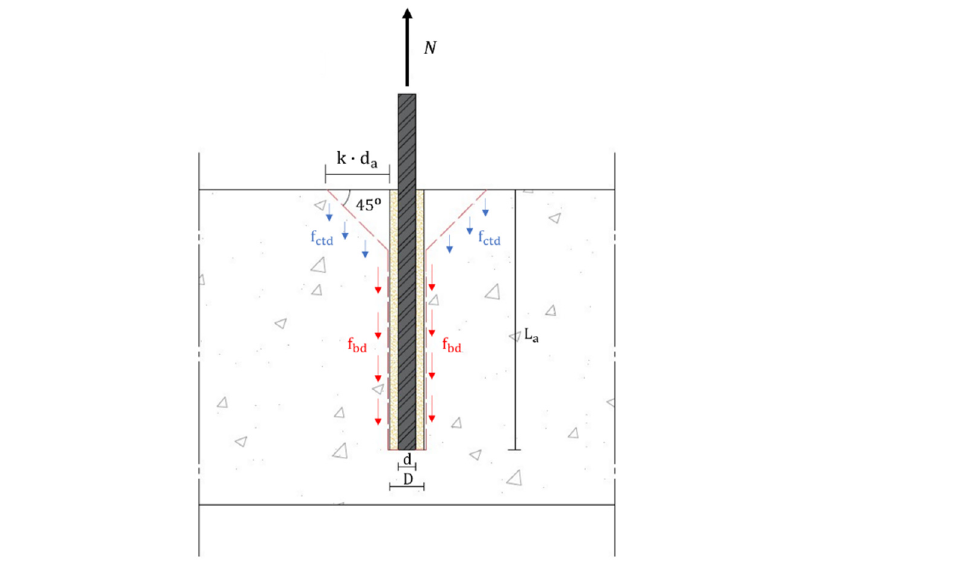
Figure 12. Structural scheme for determining the anchor length. Table 11. Steel reinforcing bars for I1 intervention ( 𝜁 (cid:3006) ≥ 1.00).